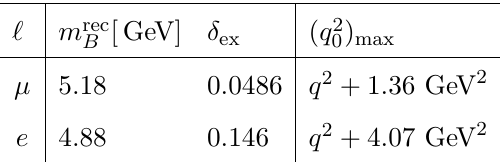
and the maximal value of q 2 0 B K